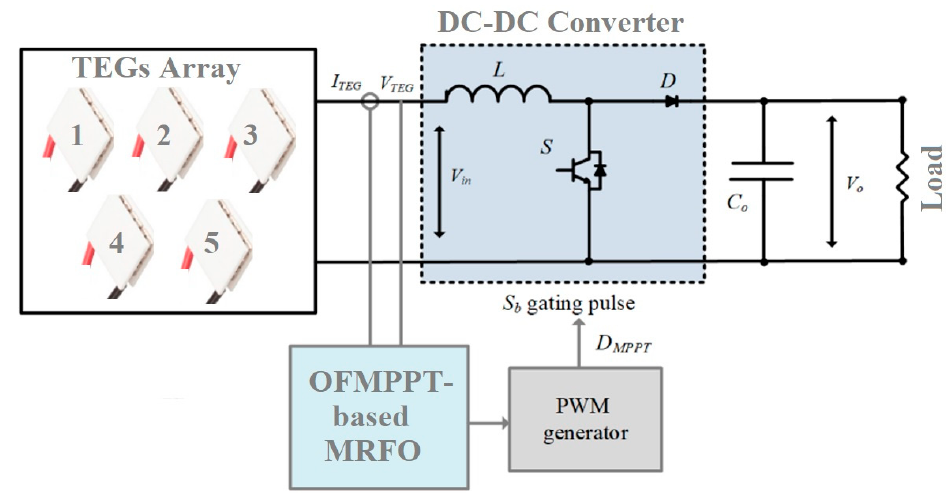
Figure 9. A complete TEG system diagram. Table 4. The details parameters for the investigated scenarios.